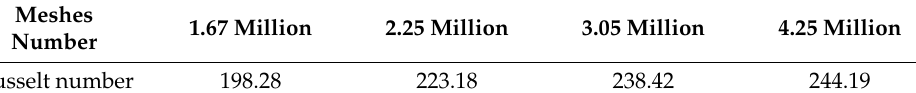
Table 2. Nusselt number for different grids.